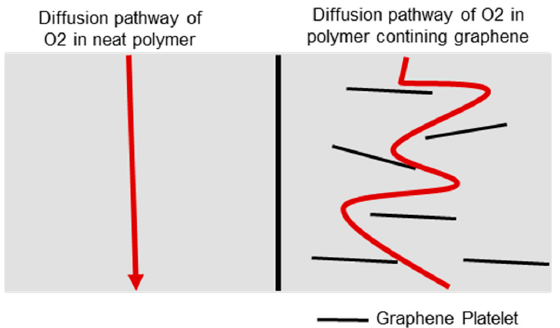
Figure 6. Pathway of oxygen diffusion in neat polymer and graphene nano-